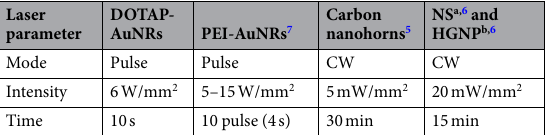
Table 1. Laser illumination parameters used in photoactivation studies with nanomaterials. a Silica-gold nanoshell, b Hollow gold